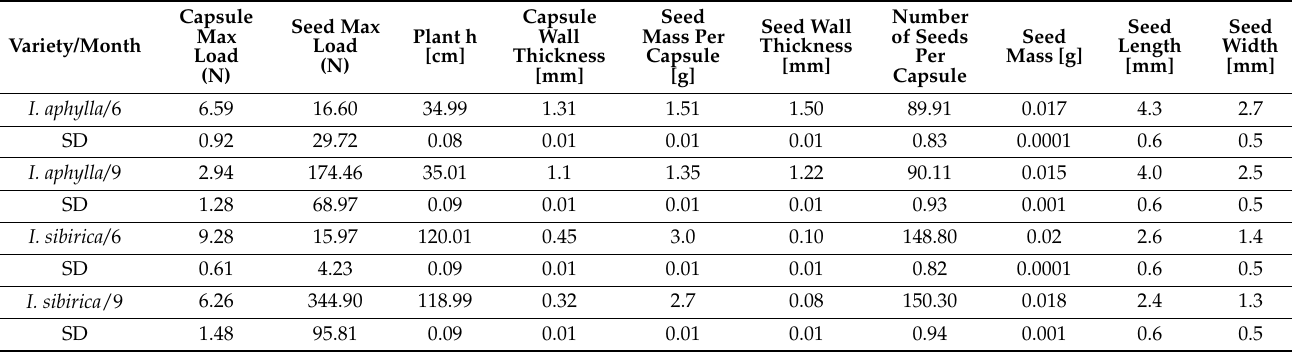
Table 1. Morphological traits and mechanical properties of I. aphylla and I. sibirica seed capsules and seeds analyzed in June (6) and September